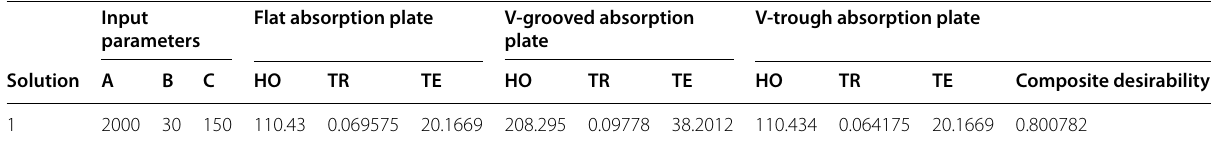
Table 8 Optimal results for parameters and